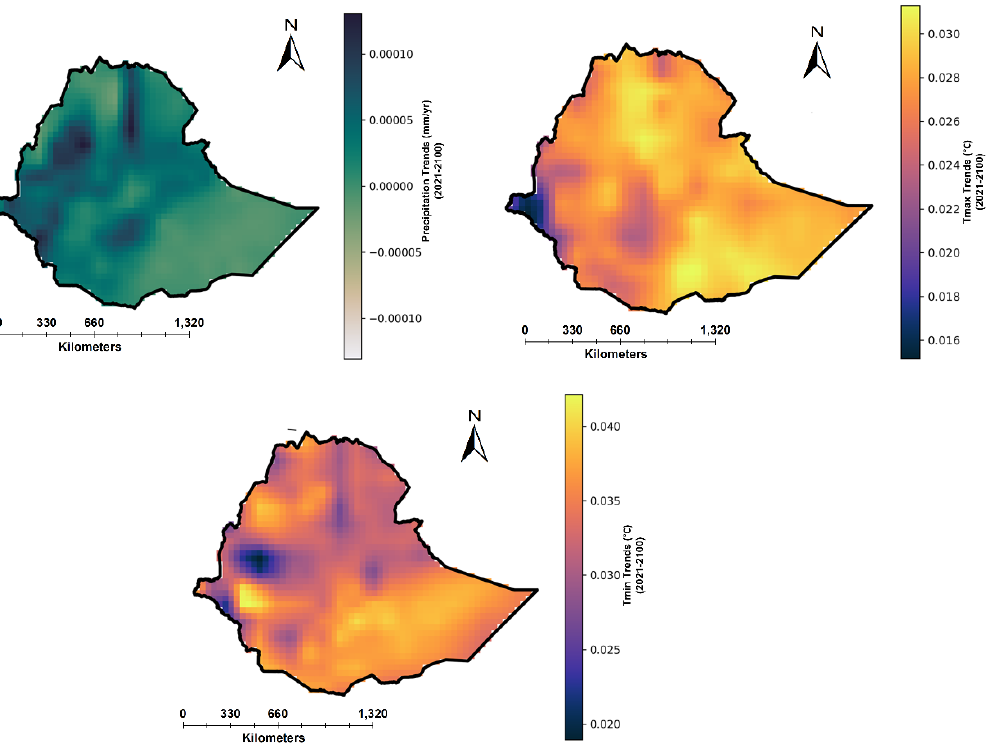
Figure 7. Spatial distribution of the future precipitation, maximum and minimum temperature trend (slope of the linear regression) map for 2021–2100 in the study of Ethiopia.